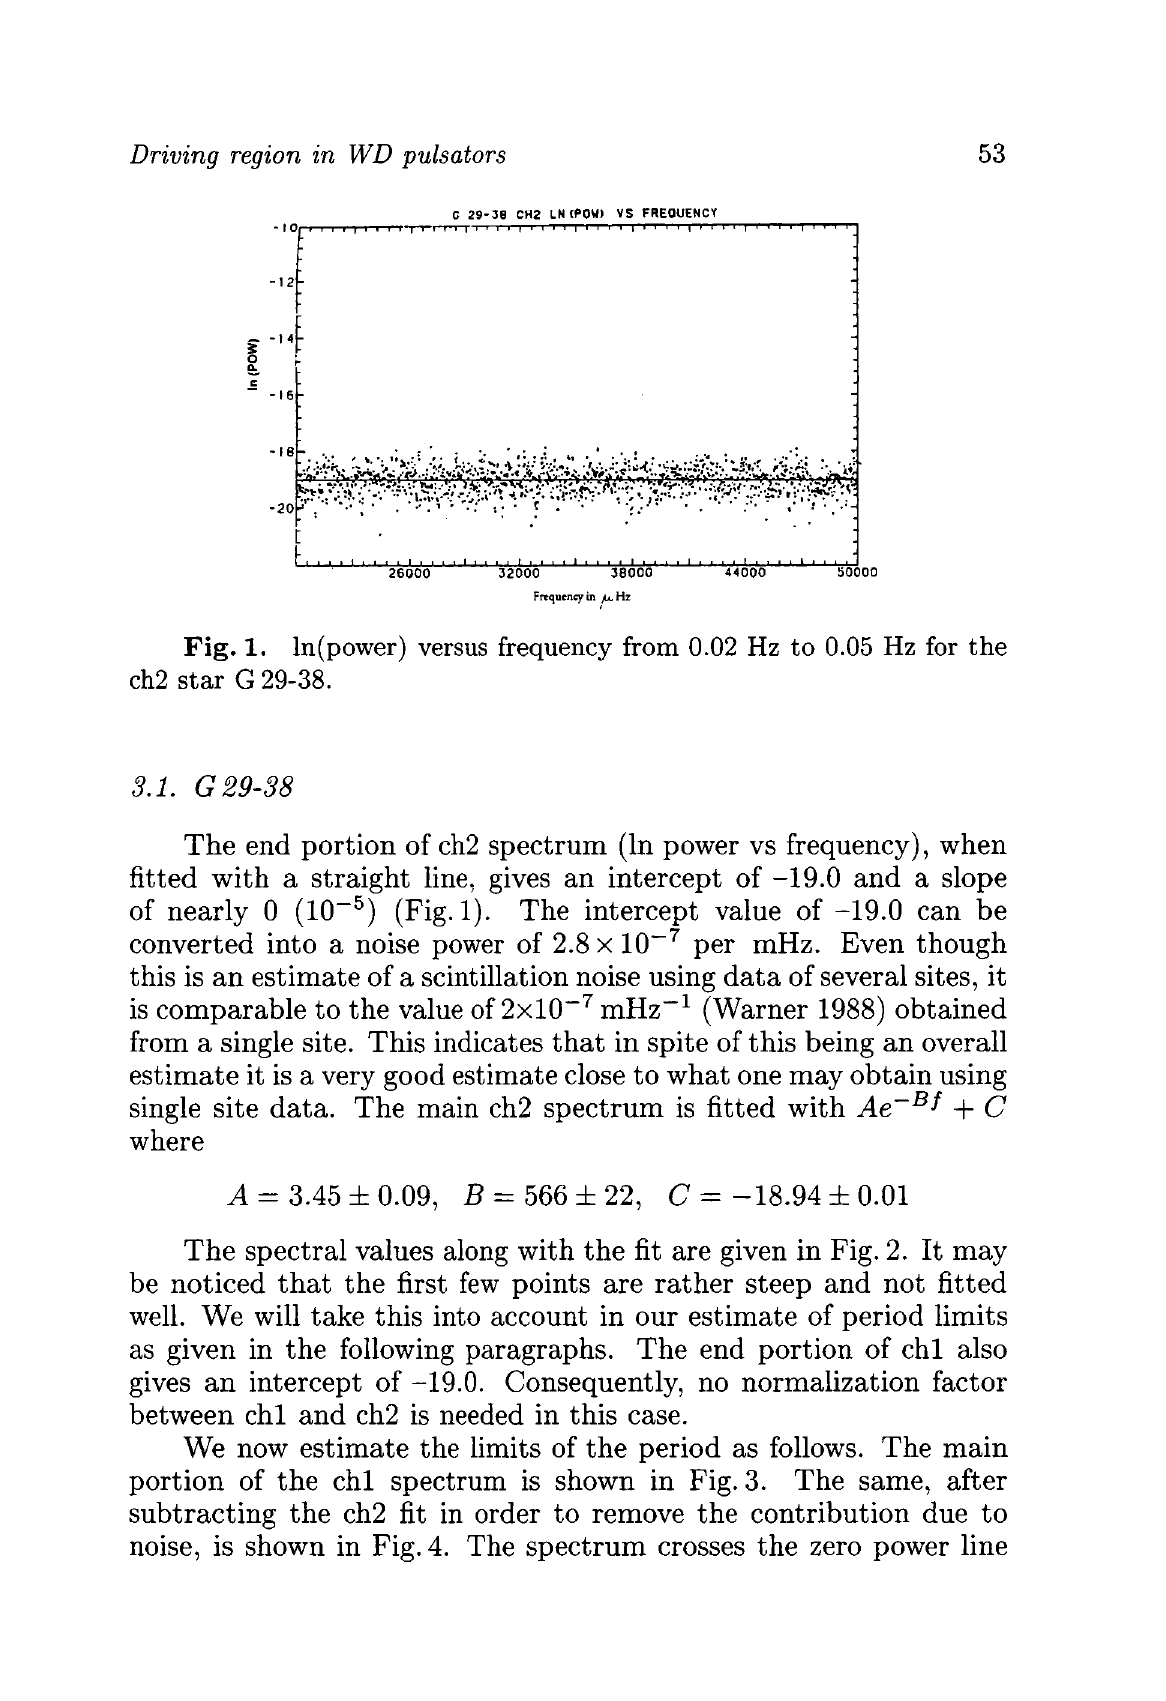
Fig. 1. ln(power) versus frequency from 0.02 Hz to 0.05 Hz for the ch2 star G 29-38.